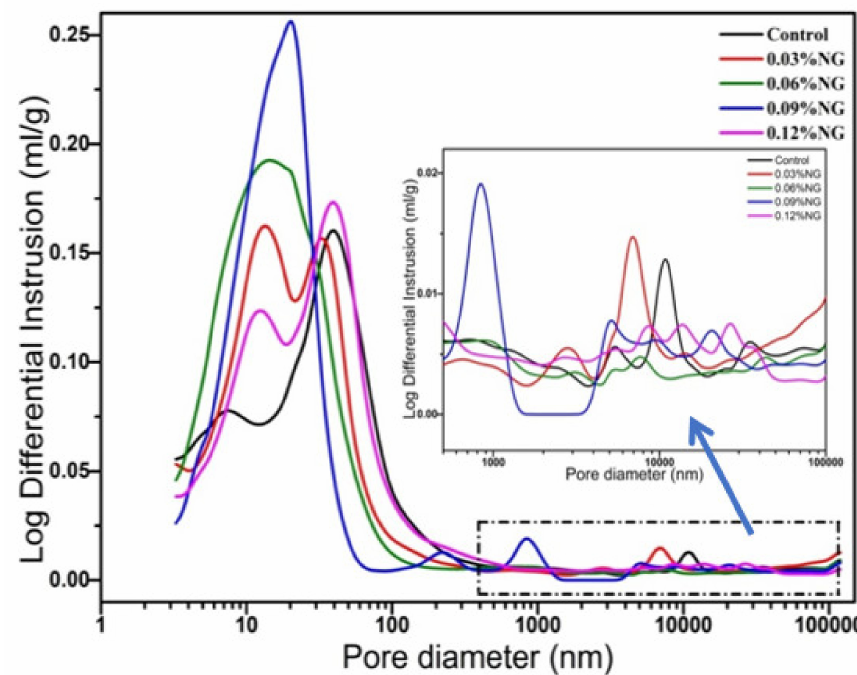
Figure 5. Effect of GO on pore size distribution.